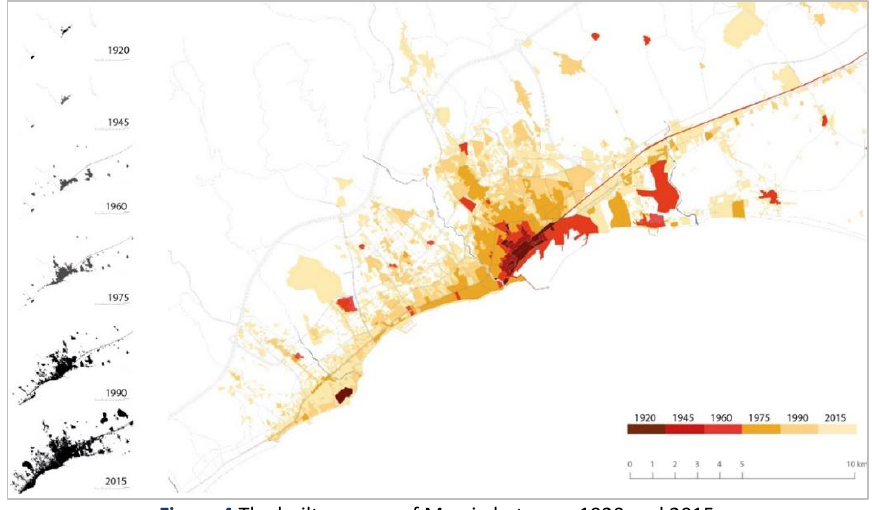
Figure 4 The built-up area of Mersin between 1920 and 2015.